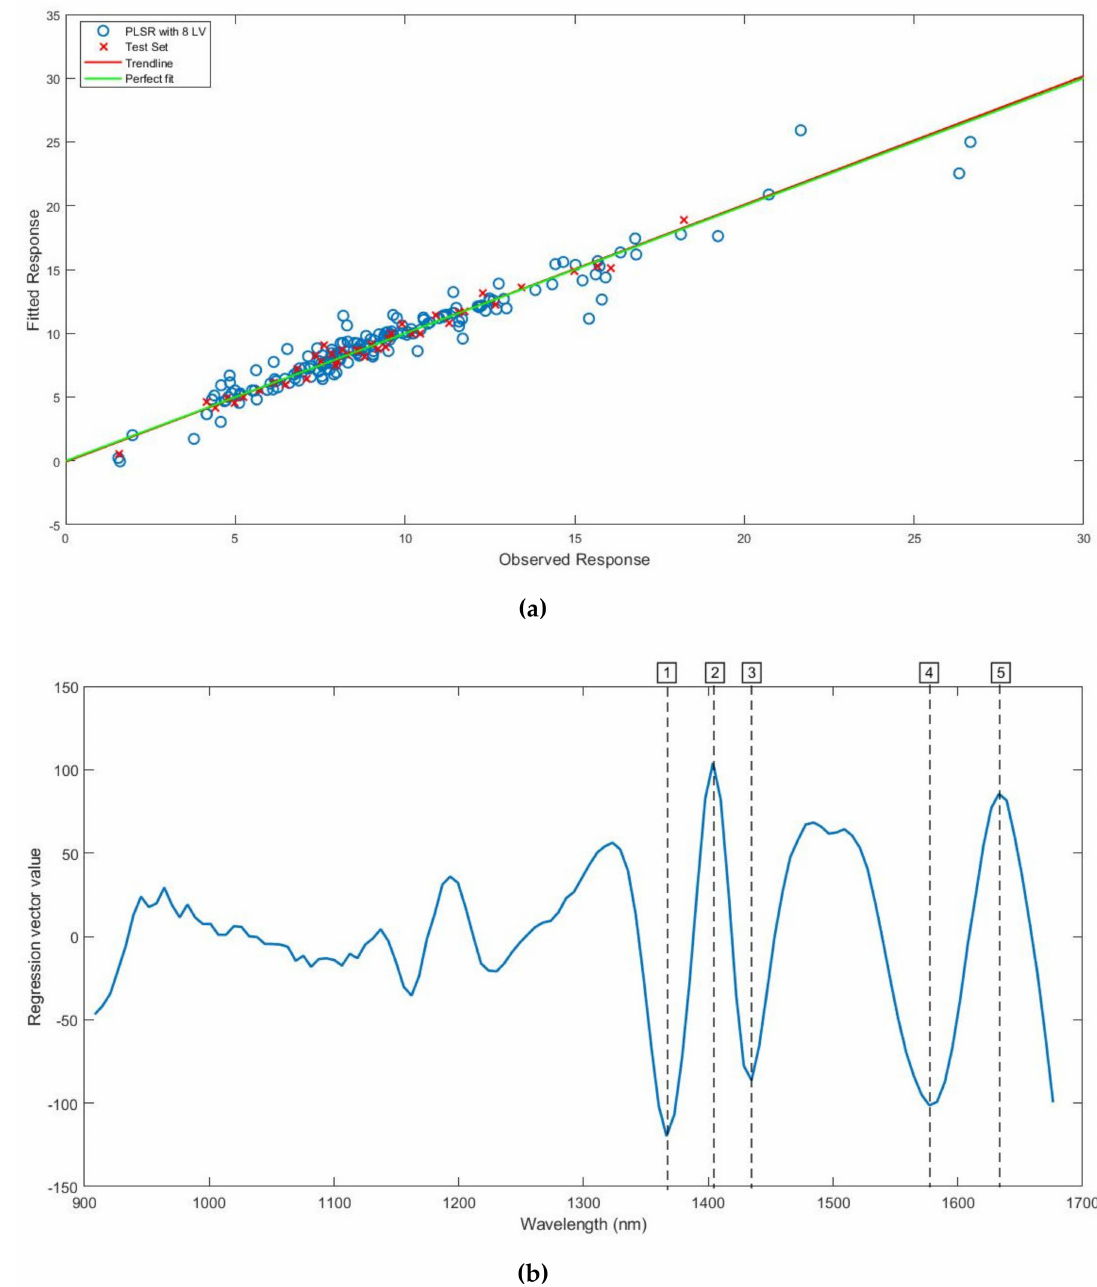
Figure 3. ( a ) Partial least squares regression plot for the prediction of BWC on WD gr . Raw spectra were pre-processed with no pretreatments using eight latent variables; ( b ) Corresponding regression vector plot using vertical lines and numbers to highlight the most important